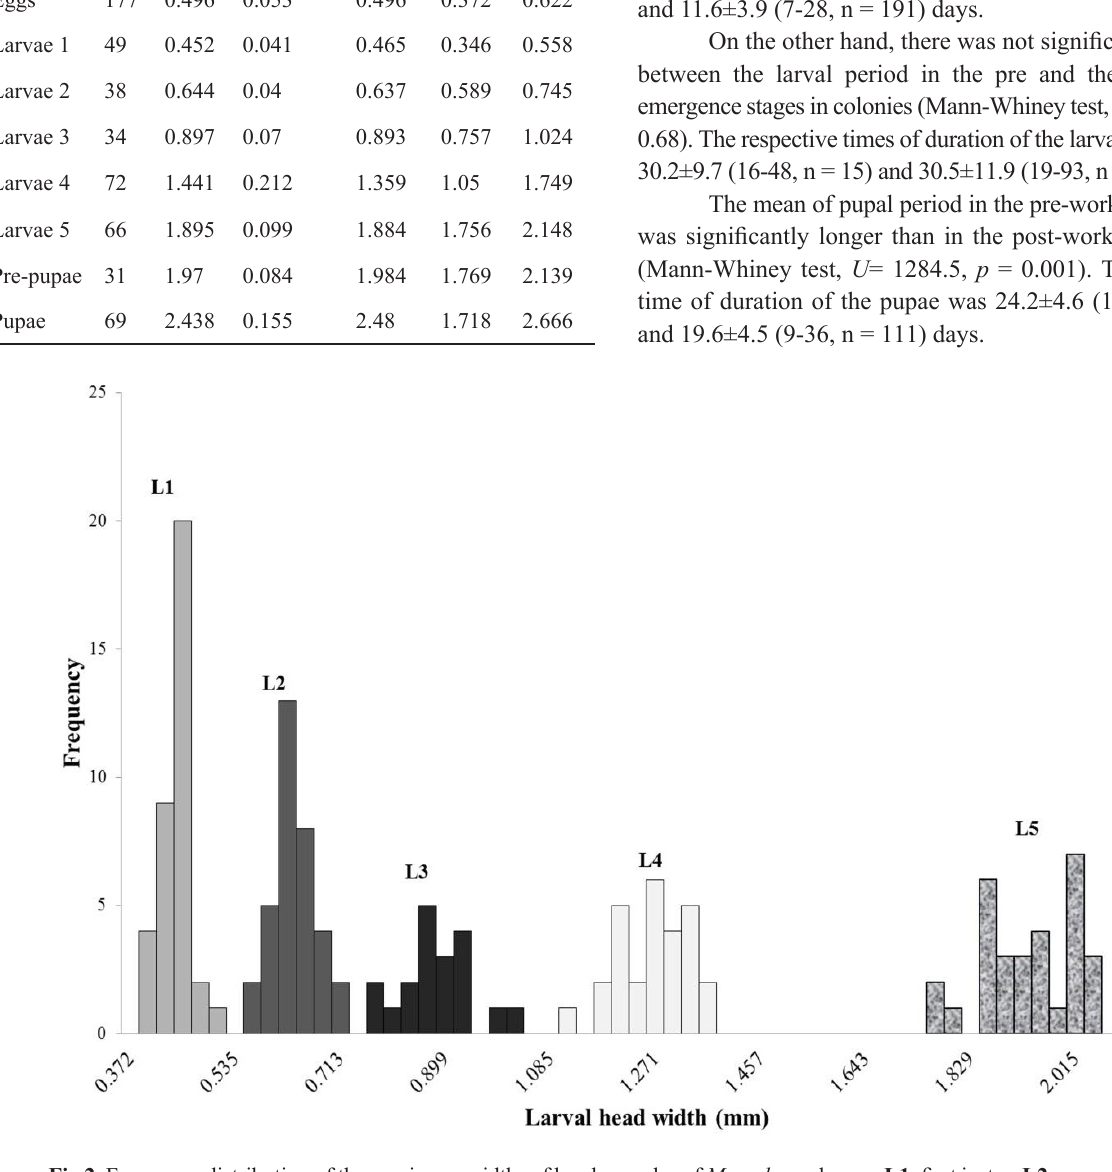
Fig 2 . Frequency distribution of the maximum widths of head capsules of M. cerberus larvae. L1 : first instar; L2 : second instar; L3 : third instar; L4 : fourth instar and L5 : fifth